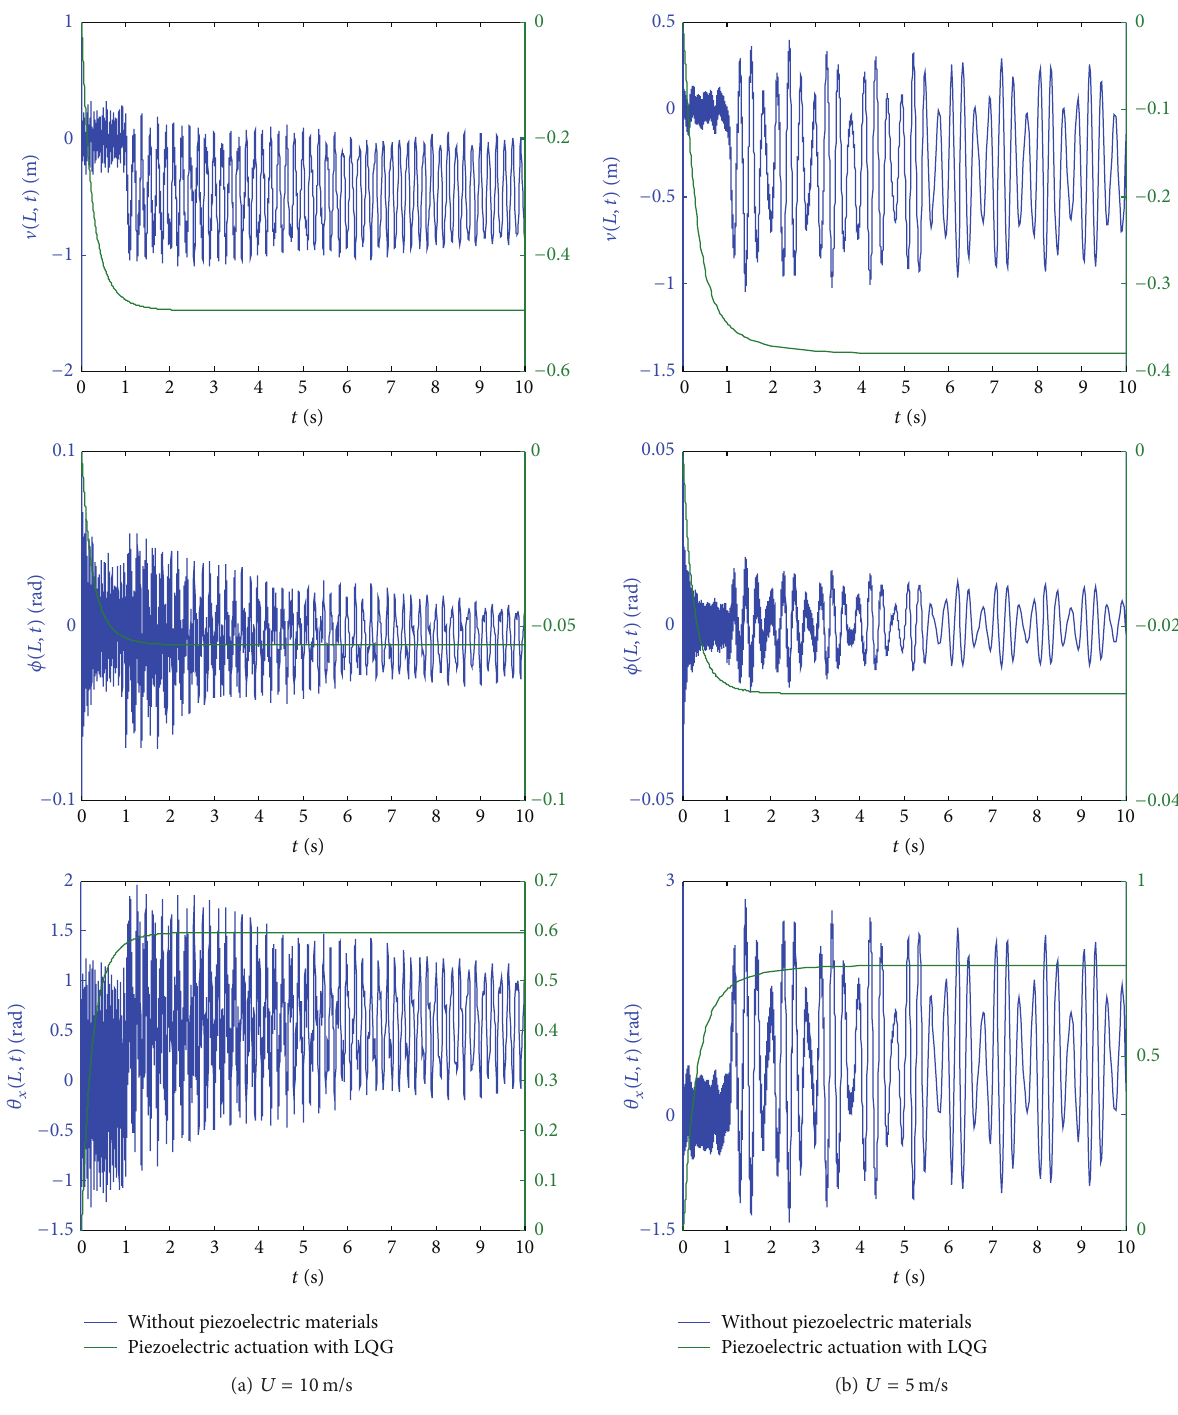
Figure 7: The time responses of the three displacements for wind velocities of 𝑈 = 10 m/s (a) and 𝑈 = 5 m/s (b), which are characterized by the state without piezoelectric materials and actuation by LQG